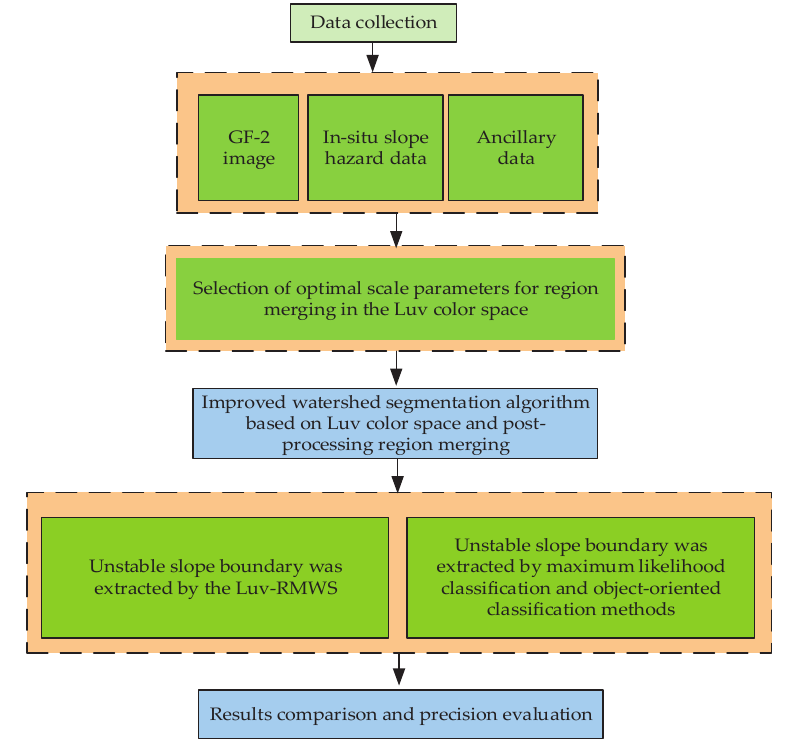
Figure 2. GF-2 remote sensing images: ( a ) original image and ( b ) contrast-enhanced image.